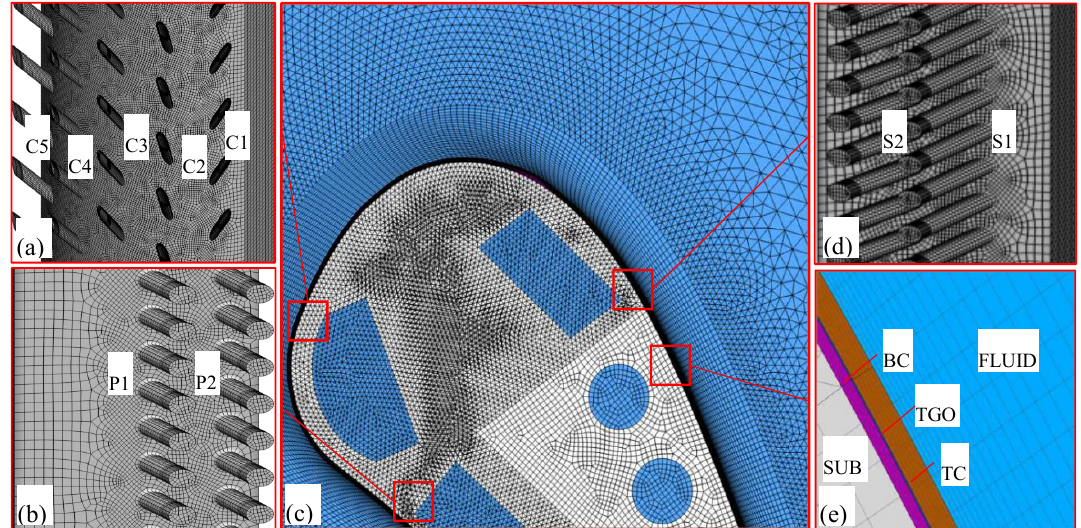
Figure 3. Computational grids. ( a ) leading edge film cooling holes, ( b ) pressure side film cooling holes, ( c ) computational grids, ( d ) suction side film cooling holes, ( e ) multilayered thermal barrier coatings (TBCs).